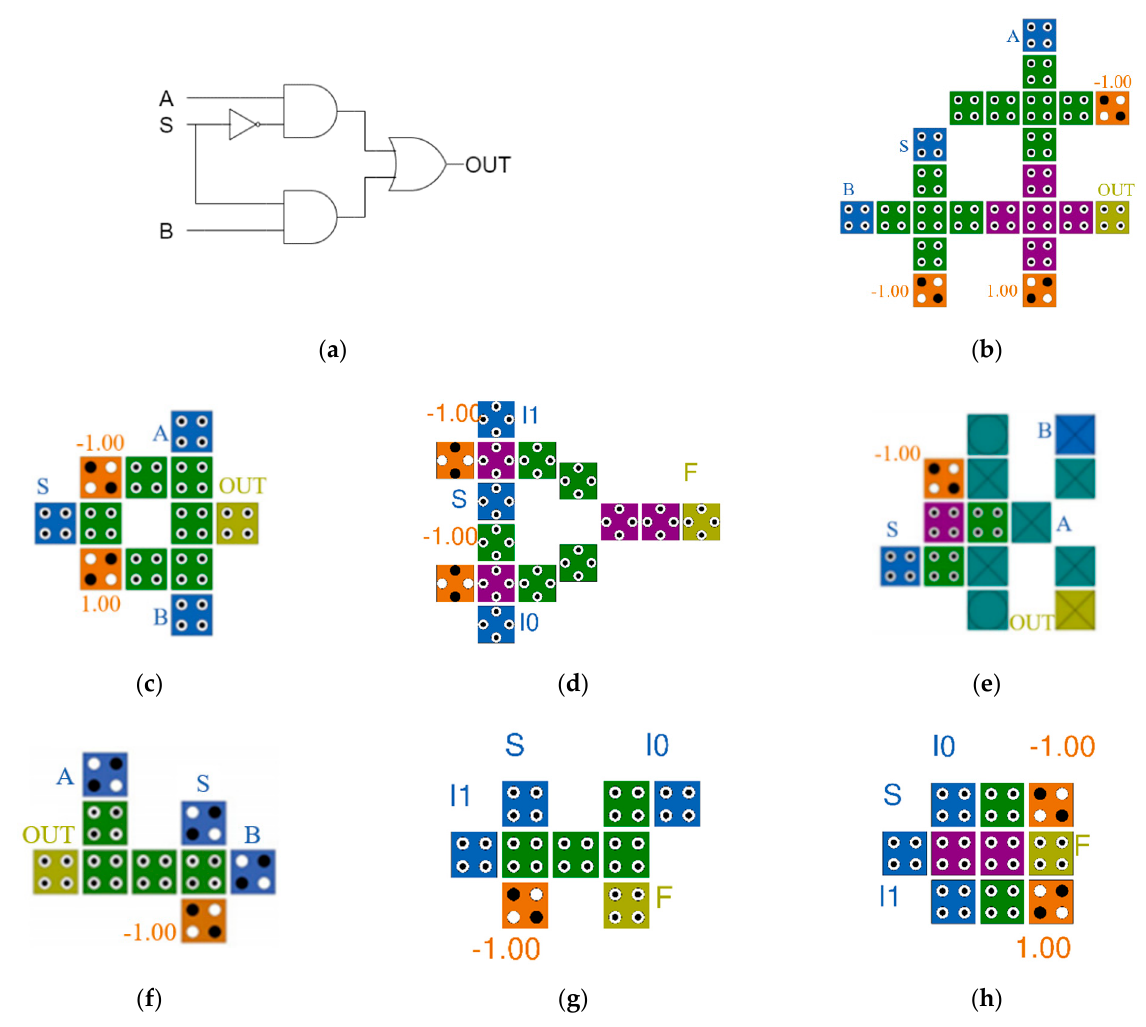
Figure 4. Previous 2-to-1 Muxes: ( a ) a logic diagram of 2-to-1 multiplexer; ( b ) B. Sen et al.’s [12]; ( c ) M. N. Asfestani et al.’s [13]; ( d ) D. Ajitha et al.’s [14]; ( e ) M. Mosleh’s [15]; ( f ) A. H. Majeed et al.’s [16]; ( g )